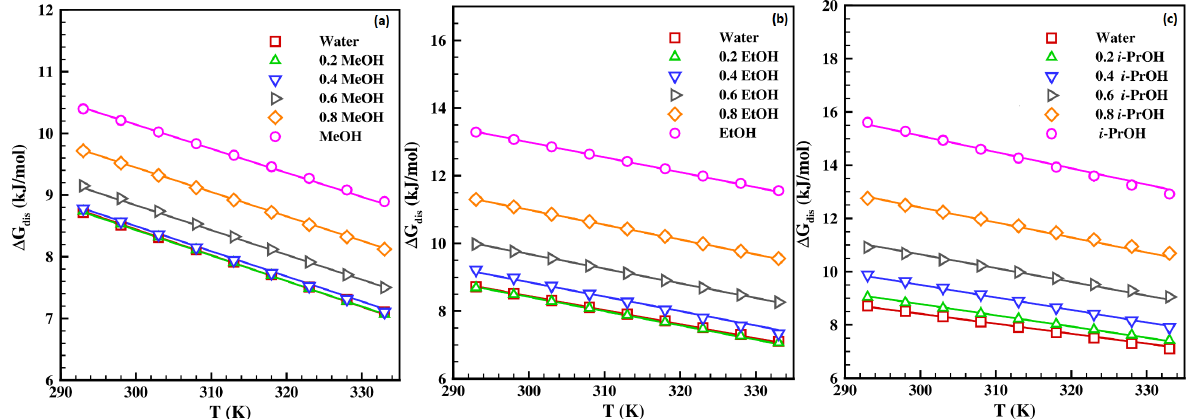
Figure 9. Plot of change in Gibbs free energy with alcohol composition in: ( a ) Water-Methanol, ( b ) Water-Ethanol and ( c ) Water-Isopropanol binary solvent system. Symbols: Enthalpy using Van’t Hoff (Equation (12)); Solid lined: Enthalpy using Jouyban-Acree model parameters (Equation